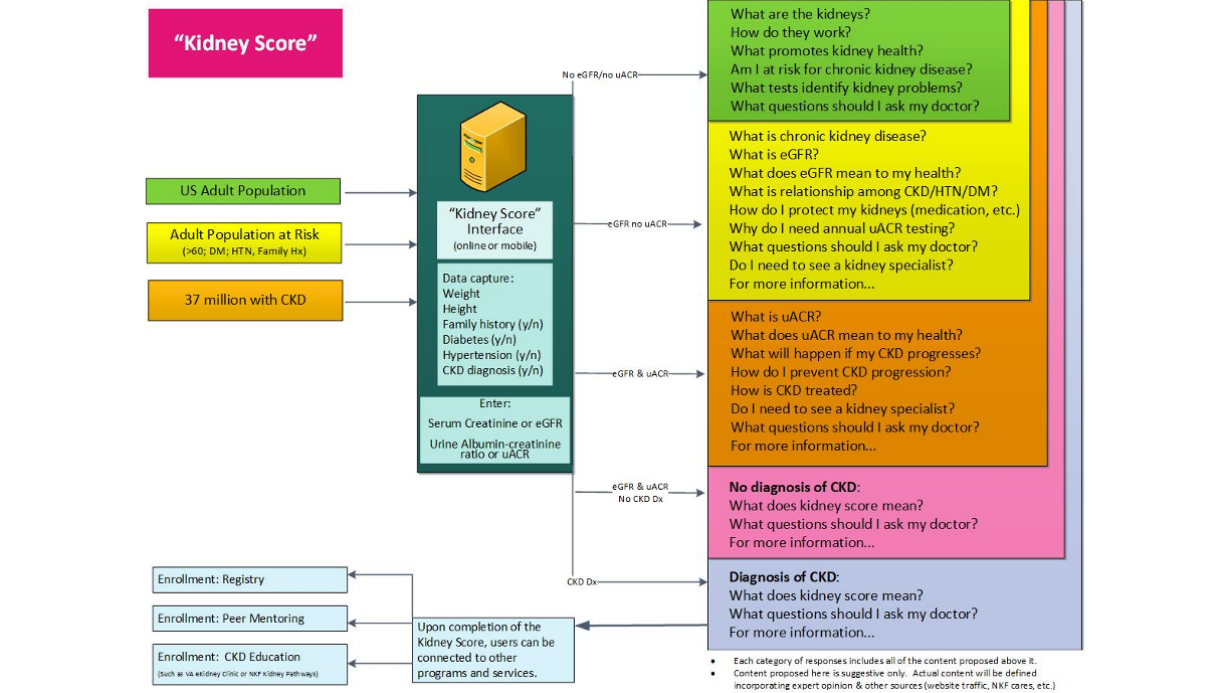
Figure 2. Design of the Kidney Score Platform online interface, which utilizes a rule engine and risk predictive analytics to provide interactive health information tailored to the individual’s chronic kidney disease risk and health status. CKD: chronic kidney disease; eGFR: estimated glomerular